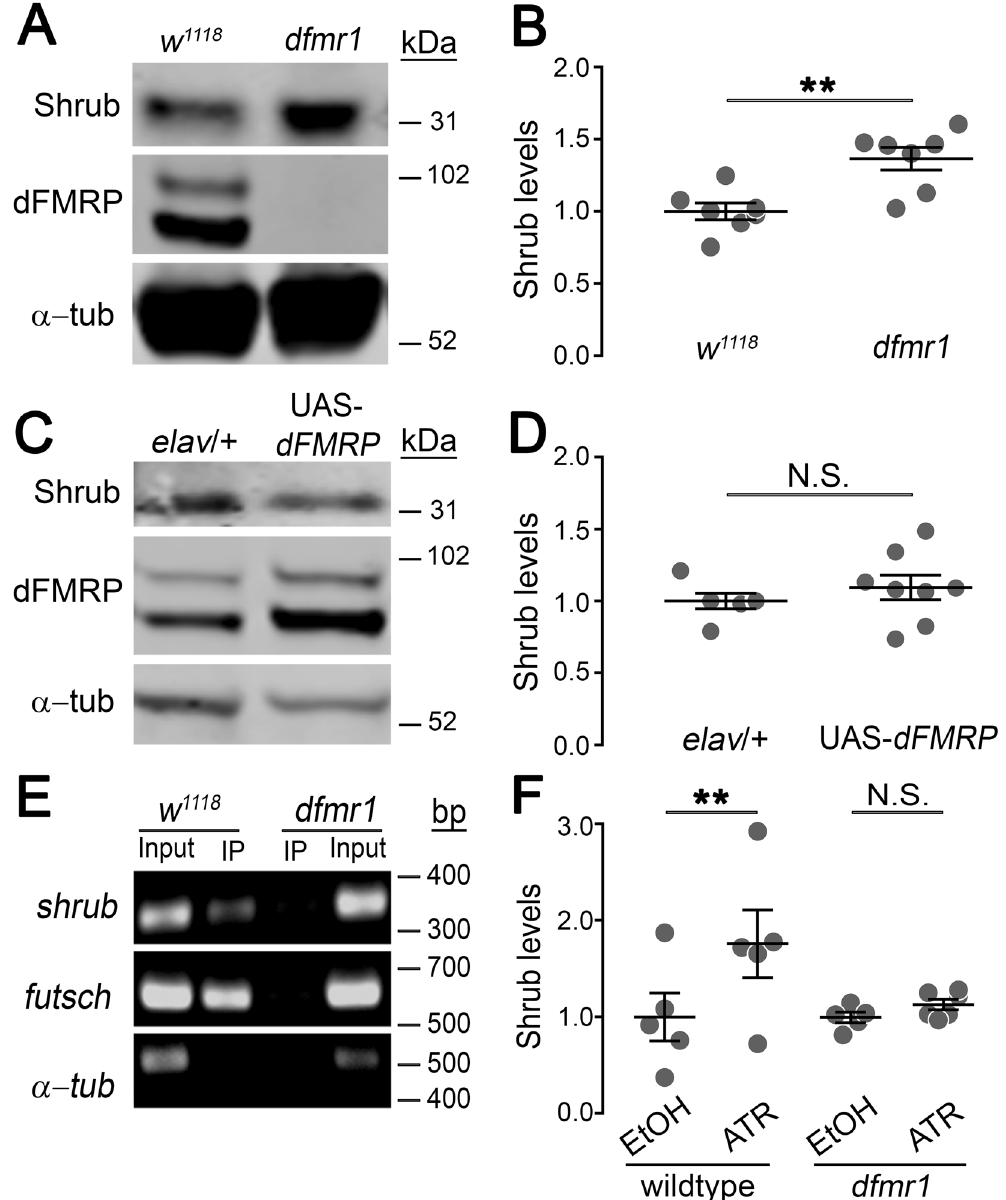
Figure 1. FMRP negatively regulates brain Shrub levels during the A–D critical period. ( A ) Brain Western blot comparing w 1118 background control to dfmr1 50M null mutant at 0–3 hr post eclosion (3PE). Proteins probed indicated on left, molecular weights on right. ( B ) Dot plots of the normalized Shrub data points, with mean ± SEM. ( C ) Brain Western blot comparing driver control ( elav -Gal4/ + ) to UAS-dFMRP rescue ( elav - Gal4/ + ; UAS- dfmr1 9557–3 , dfmr1 50M /dfmr1 50M ) at 3PE. Proteins probed indicated on left, molecular weights on right. ( D ) Dot plots of normalized Shrub data points, with mean ± SEM. ( E ) RNA immunoprecipitation (RIP) comparing w 1118 control to dfmr1 50M null. RNAs probed indicated on left, molecular weights on right. ( F ) Optogenetic control of Shrub in elav -Gal4/UAS-ChR2(H134R)-mCherry control animals (left) and elav - Gal4/UAS-ChR2(H134R)-mCherry; dfmr1 50M mutants (right) reared on EtOH vehicle (not stimulated) or ATR (stimulated) food. Animals were illuminated with 5 Hz blue light for 2 hr, with brains tested by anti-Shrub Western blot. Dot plots of normalized Shrub data points, with mean ± SEM. Statistics done with two tailed unpaired t-tests, indicated as ** P < 0.01 and N.S. P >